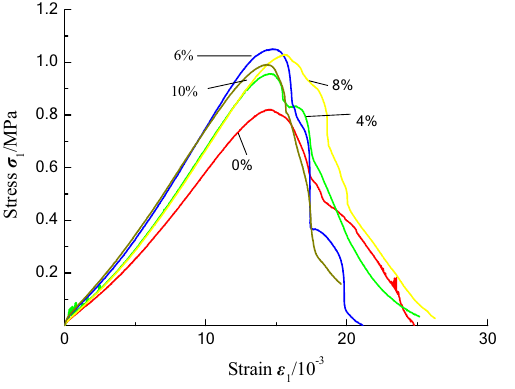
Figure 9. Stress–strain curves of the coal briquette samples with different moisture contents under uniaxial compression.